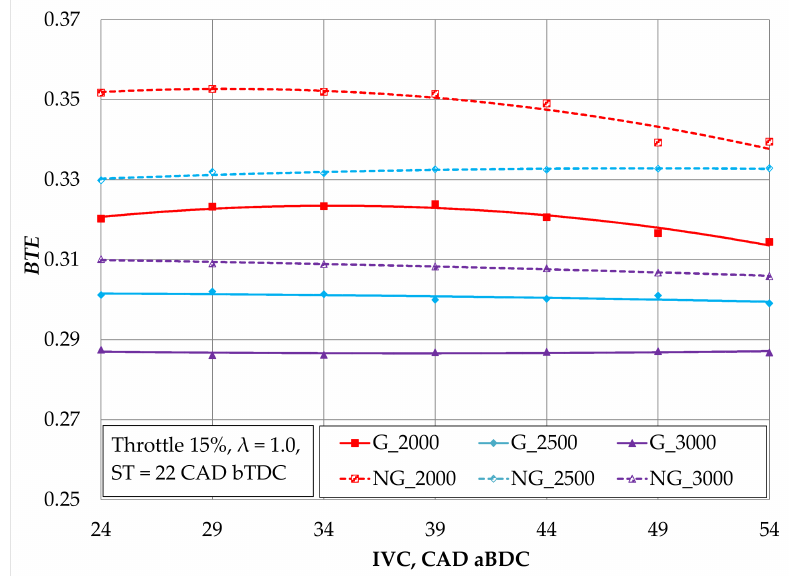
Figure 8. Brake thermal efficiency while running on gasoline and natural gas and while changing the intake valve close